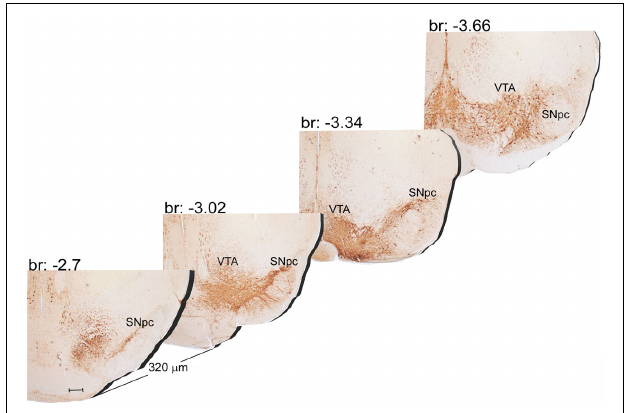
FIGURE 1 | Rostro-caudal reconstruction of the VTA and SNpc catecholamine nuclei. TH immunostaining in 20 µ m coronal mouse brain sections regularly collected every 320 µ m from –2.7 to –3.66 Bregma levels. The figure shows a 3D-like antero-posterior reconstruction of the VTA and SNpc nuclei. Scale bar: 200 µ m.